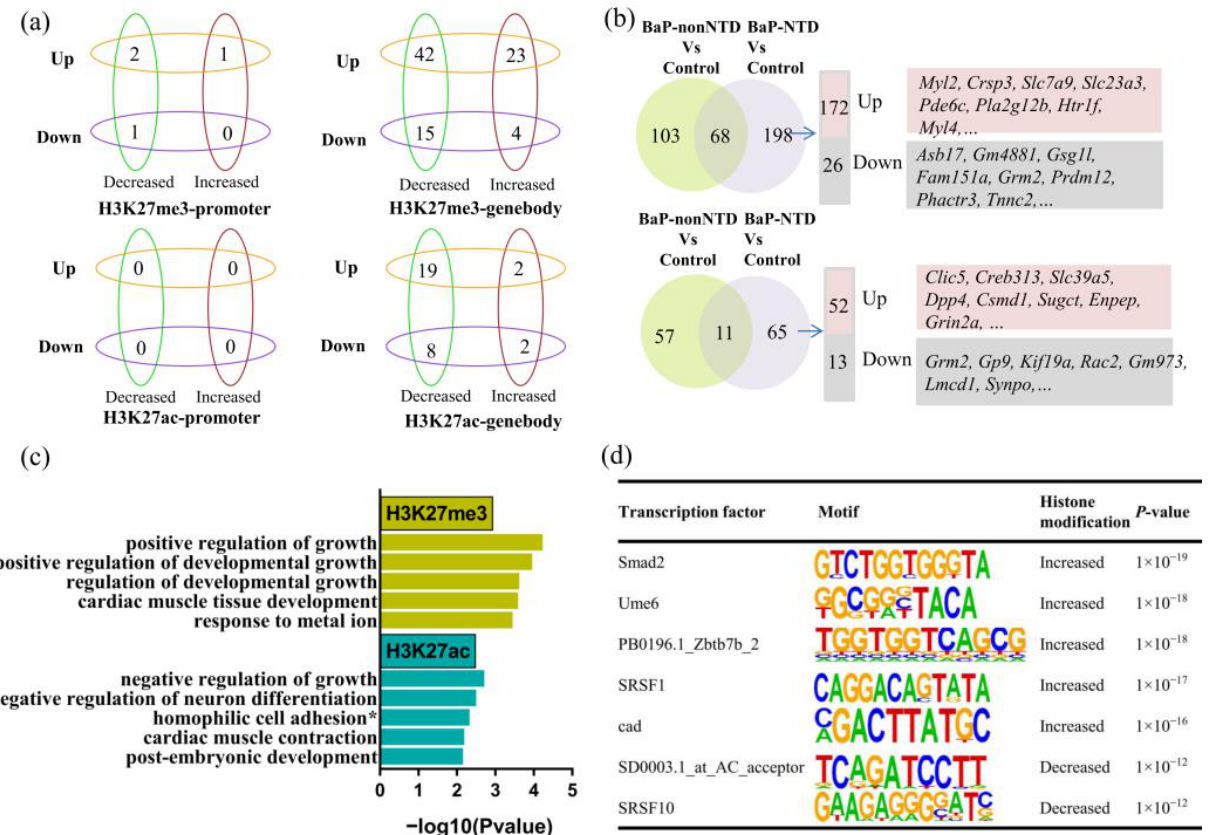
Figure 5. Combined analysis of CUT&Tag and RNA-seq. ( a ) The relationships between fold change of CUT&Tag signals for H3K27me3/H3K27ac and fold change of gene expression in BaP-NTD-vs- BaP-nonNTD comparison. ( b ) Venn diagram showing the overlap differentially transcribed genes with a H3K27me3 or H3K27ac modification. The BaP-NTD-vs-control comparisons unique DEGs are listed, ordered by fold change of gene expression. ( c ) GO analysis of the BaP-NTD-vs-BaP- nonNTD comparisons with a H3K27me3 or H3K27ac modification. ( d ) Analysis using HOMER for differentially modified H3K27me3 regions revealed eight significant motifs. * homophilic cell adhesion via plasma membrane adhesion